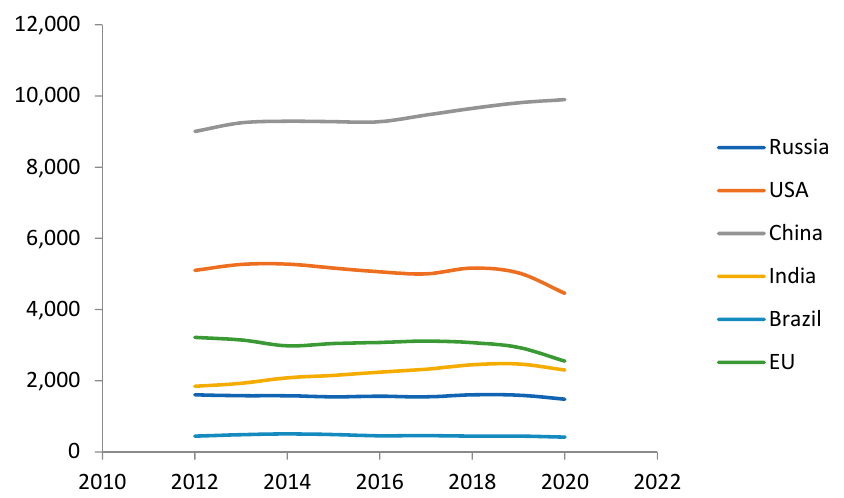
Figure 4. The illustrated dynamics of CO 2 emissions by the main producing countries shows the predominant influence of China on global CO 2 emissions. According to the graph, China is increasing CO 2 emissions by increasing production. Data according to the BP study, million tons.